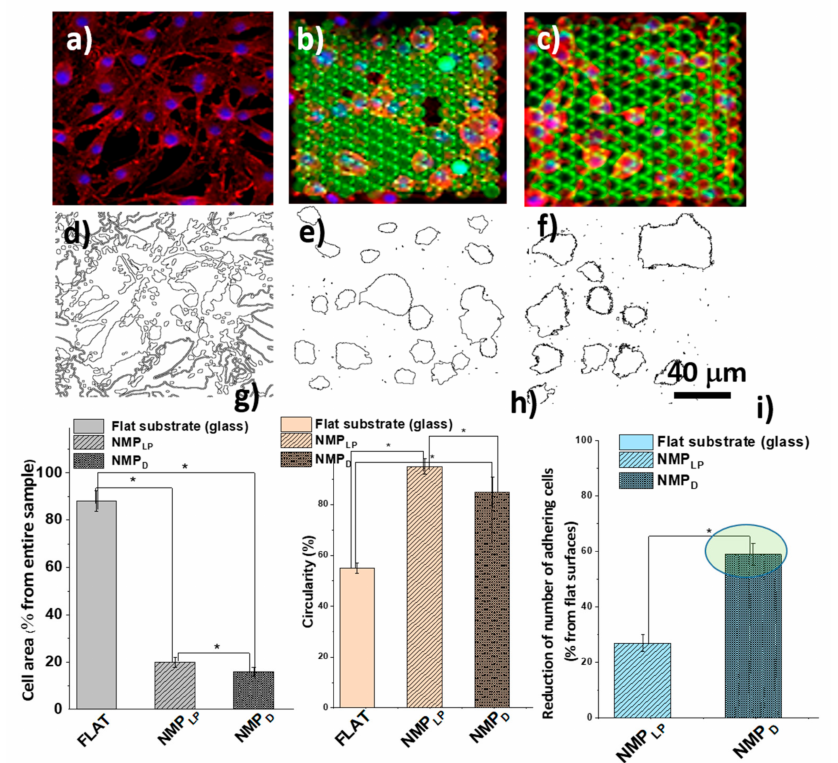
Figure 7. Fluorescent images of cells on: ( a ) glass (control), ( b ) nanostructured mushroom-like pillars with optimized laser power (NMPLP), ( c ) nanostructured mushroom-like pillars with optimized de- sign (NMPD); green: structures’ autofluorescence; blue: cells nuclei, Hoechst; red: cells cytoskeleton, Phalloidin; ( d – f ) image processing by Image J showing only the cells’ outlines; ( g – i ) cells area, cells circularity and reduction of adhering cells for flat, NMP LP and NMP D structures, respectively. The scale (40 µ m) from ( f ) is valid for all figures, i.e., ( a – f ). The sign “*” from ( g – i ) indicate that the data are statistically